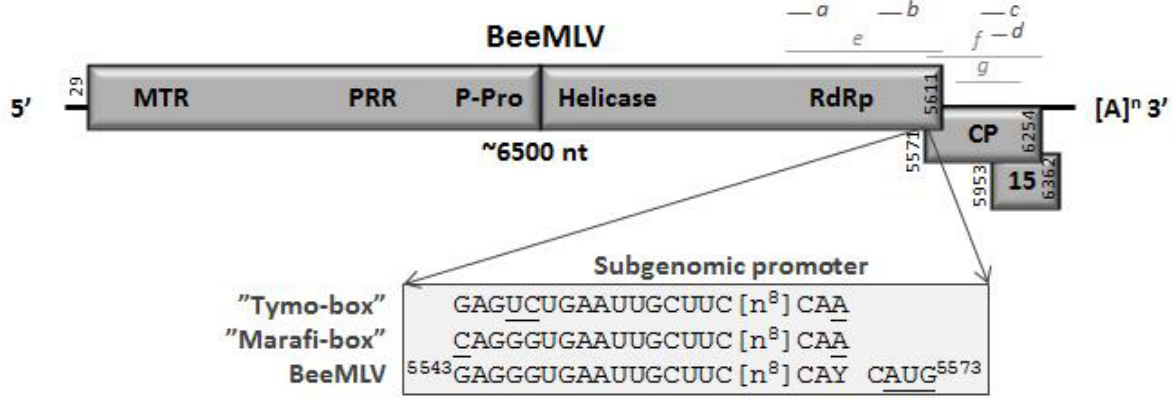
Figure 1. Genome organization of BeeMLV. The estimated genome size is indicated as are the presence of a natural 3′ poly-A tail and the location of overlapping open reading frames coding for the capsid protein (CP), an unknown 15 kD protein (P15) and the large polyprotein containing the domains MTR (methyl transferase), PRR (Proline-rich region), P-Pro (endo-peptidase), Helic (NTPase/helicase) and RdRp (RNA-dependent RNA polymerase), separated by the location of the putative P-Pro cleavage site in between the P-Pro and Helic domains. Additionally indicated are the location and sequence of the putative BeeMLV sub-genomic RNA promoter, compared to its homologues for the Tymo- and Marifiviruses. The lines above the genome map identify the locations of the nucleotide ( a ) and RdRp ( b ) plus CP ( c ) amino acid sequences used in the phylogenetic analyses (light grey) and of the quantitative RT-qPCR assays for either genomic ( d , e ) or sub-genomic + genomic ( f , g ) virus RNA quantification (dark grey).